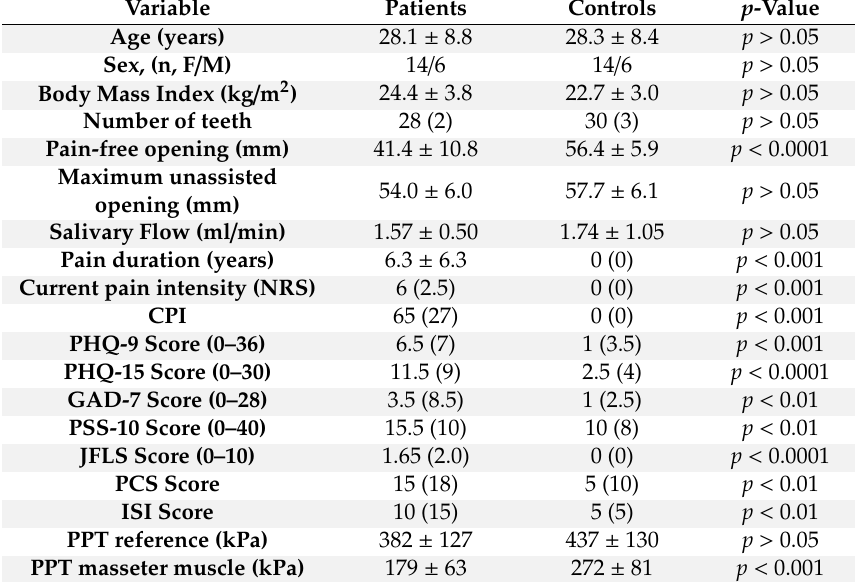
Table 1. Descriptive data. Demographic features of patients with temporomandibular disorders myalgia ( n = 20) and healthy controls ( n = 20). Questionnaire scores are presented as mean ± standard deviation or as median (interquartile range). Statistical parameters are reported only when the distributions in the two groups di ff ered significantly, p < 0.05 (t-test or Mann–Whitney U-test).